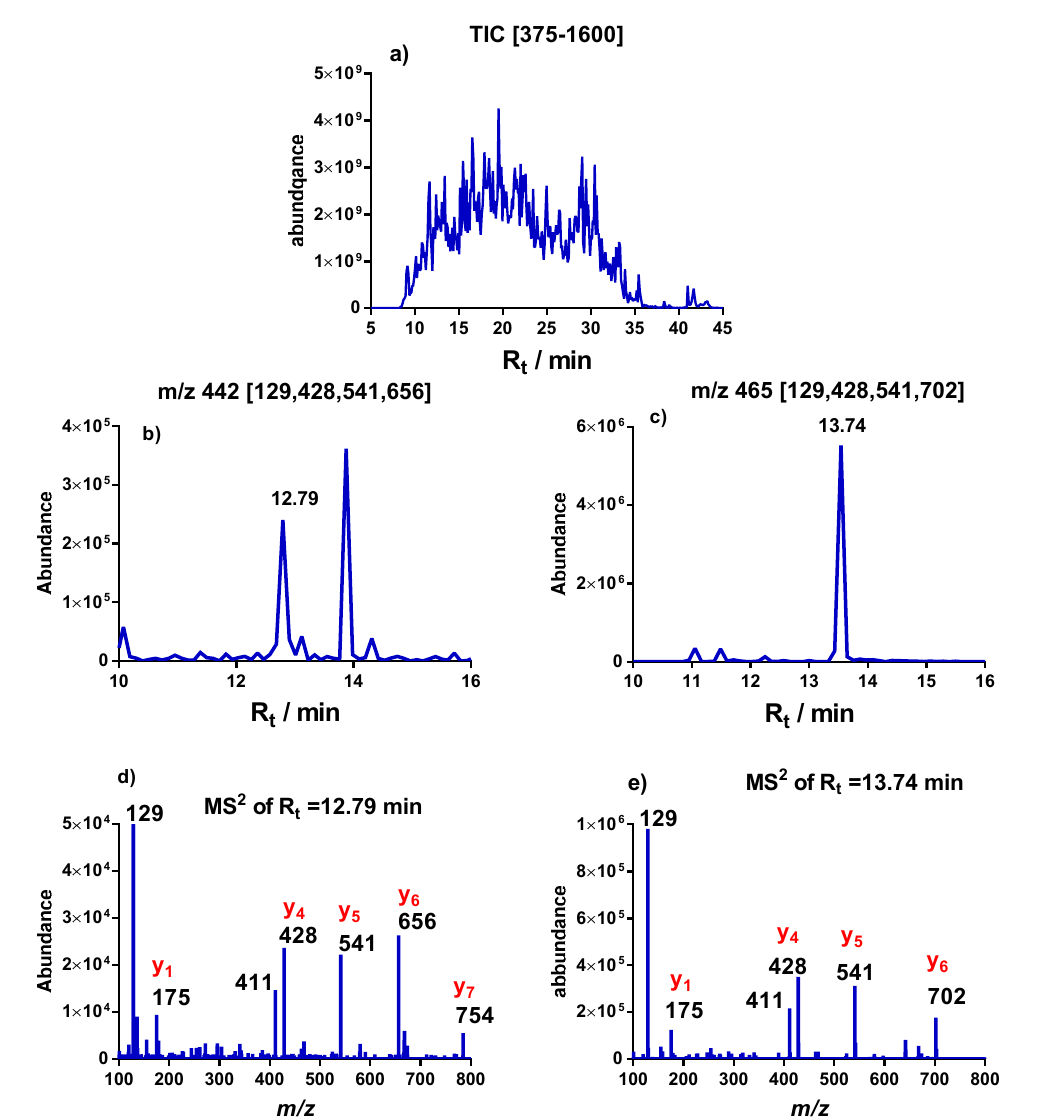
Figure 4. Targeted LC-MS analysis of a trypsin-treated wild type bacterial E. coli sample. ( a ) Total Ion Chromatogram (TIC) in the m/z interval [375–1600]. ( b , c ) Chromatograms obtained with the MS 2 filters, MS 2 442.27@hcd 35 [129, 428, 541, 656] and MS 2 465.26@hcd 35 [129, 428, 541, 702], respectively.